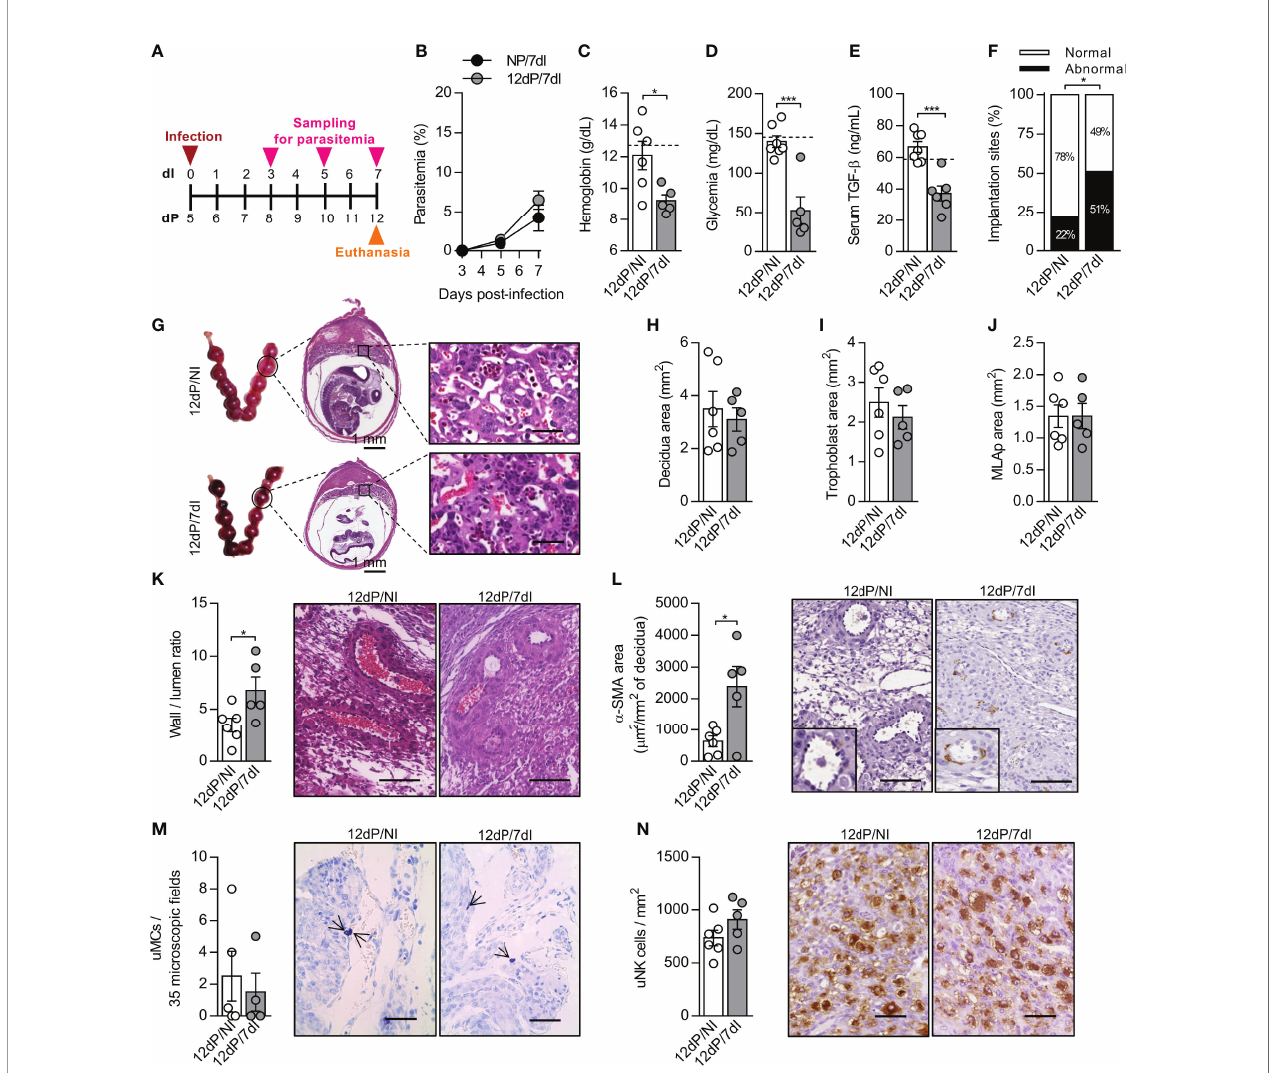
FIGURE 2 | Malaria interferes in the remodeling of spiral arteries without changes in uNK cells numbers in mid-pregnancy. (A) An experimental design for the study of malaria in mid-gestation using BALB/c mice infected with P. berghei ANKA was performed. (B) Parasitemia levels were estimated by fl ow cytometry (n = 6-7 mice/group). (C – E) Hemoglobin (12dP/NI, n=6; 12dP/7dI, n=5), blood glucose (12dP/NI, n=7; 12dP/7dI, n=5) and serum TGF- b levels were measured (12dP/NI, n=7; 12dP/7dI, n=6). The dashed lines indicate the mean results of non-pregnant uninfected mice for each parameter evaluated. (F, G) The implantations sites were classi fi ed as normal or abnormal (F) according to macroscopic aspect (12dP/NI, n=7; 12dP/7dI, n=6), histologically processed and stained by H&E (G) , scale bar 50 m m. (H – J) Decidua (H) , trophoblast (I) and MLAp (J) areas were delimited and quanti fi ed (12dP/NI, n=6; 12dP/7dI, n=5). (K) Wall-to-lumen area ratio was evaluated in the decidua of implantation sites stained by H&E (12dP/NI, n=6; 12dP/7dI, n=5), scale bar 100 m m. (L) a -SMA staining was quanti fi ed in decidual tissue for assessment of spiral arteries remodeling (12dP/NI, n=6; 12dP/7dI, n=5), scale bar 100 m m. (M) uMCs were detected and quanti fi ed in Toluidine Blue stained implantation sites (12dP/NI, n=5; 12dP/7dI, n=4), scale bar 50 m m. (N) uNK cells were detected and quanti fi ed in the decidua of DBA lectin-stained implantation sites (12dP/NI, n=6; 12dP/7dI, n=5), scale bar 50 m m. Results represent mean ± SEM. Data was analyzed by Two-way ANOVA followed by Bonferroni ’ s post-hoc comparisons tests (B) and unpaired t-test (C – F, H – N) . NP, non-pregnant, NI, non-infected, dP, days of pregnancy, dI, days of infection. *: p <0.05; ***: p